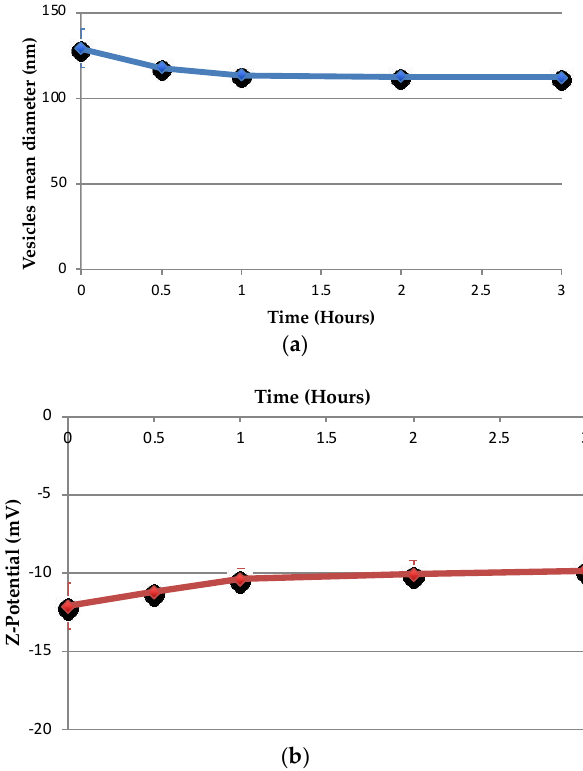
Figure 9. Changes of NioP–aCSF mixture in ( a ) hydrodynamic diameter and ( b ) ζ-potential over a 3 h period. Values represent the mean ± standard deviation of n = 3 sample measurements.